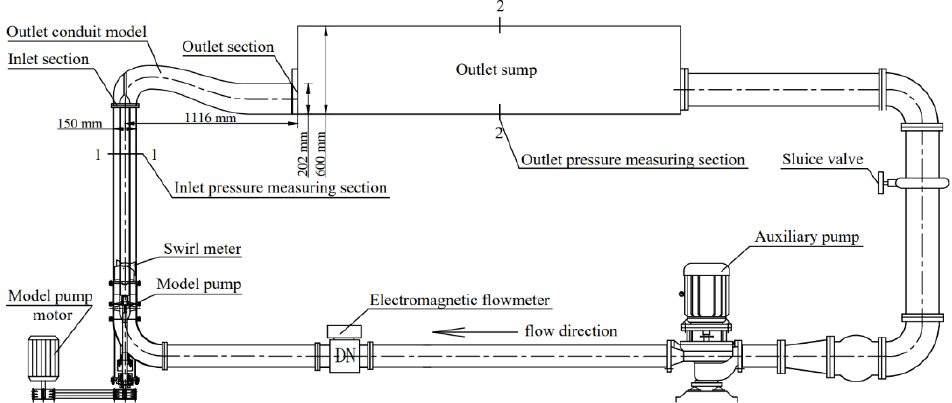
Figure 7. Schematic diagram of model test vertical circulation system of low hump outlet conduit.